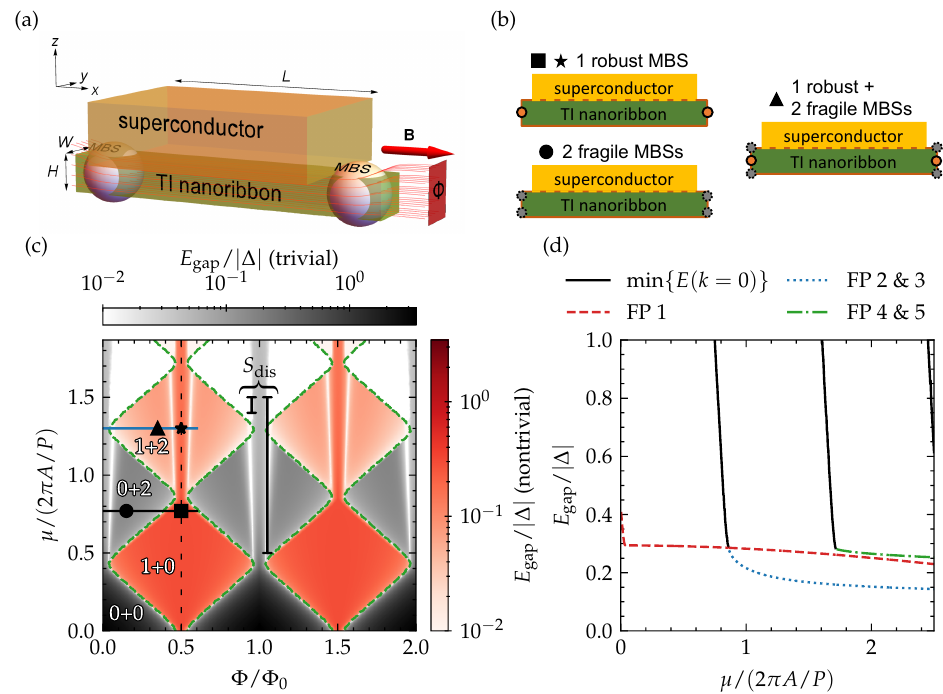
Figure 1. ( a ) A 3D TI nanoribbon that is proximitized by an s -wave superconductor via its top surface and pierced by a magnetic flux originating from an external magnetic field oriented along the ribbon. With this setup, MBSs form at opposite ends of the nanoribbon. The setup has different phases with different numbers of robust and fragile MBSs, which are shown schematically in ( b ); ( c ) the spectral gap in the proximitized TI nanoribbon as a function of magnetic flux and chemical potential. The grayscale (redscale) colormap indicates whether the gap is topologically trivial (nontrivial). The phase boundaries between the trivial and nontrivial regions are indicated with green dashed lines. The number of robust plus the number of fragile MBS pairs is indicated for some representative phases; ( d ) a line cut of the spectral gap shown in ( c ) as a function of chemical potential with magnetic flux equal to half a flux quantum (indicated by a vertical black dotted line in ( c )). The gap of each surface-state subband that has a Fermi point (FP) when ∆ = 0 is presented separately, as well as the gap of the lowest subband without Fermi point, evaluated at k =